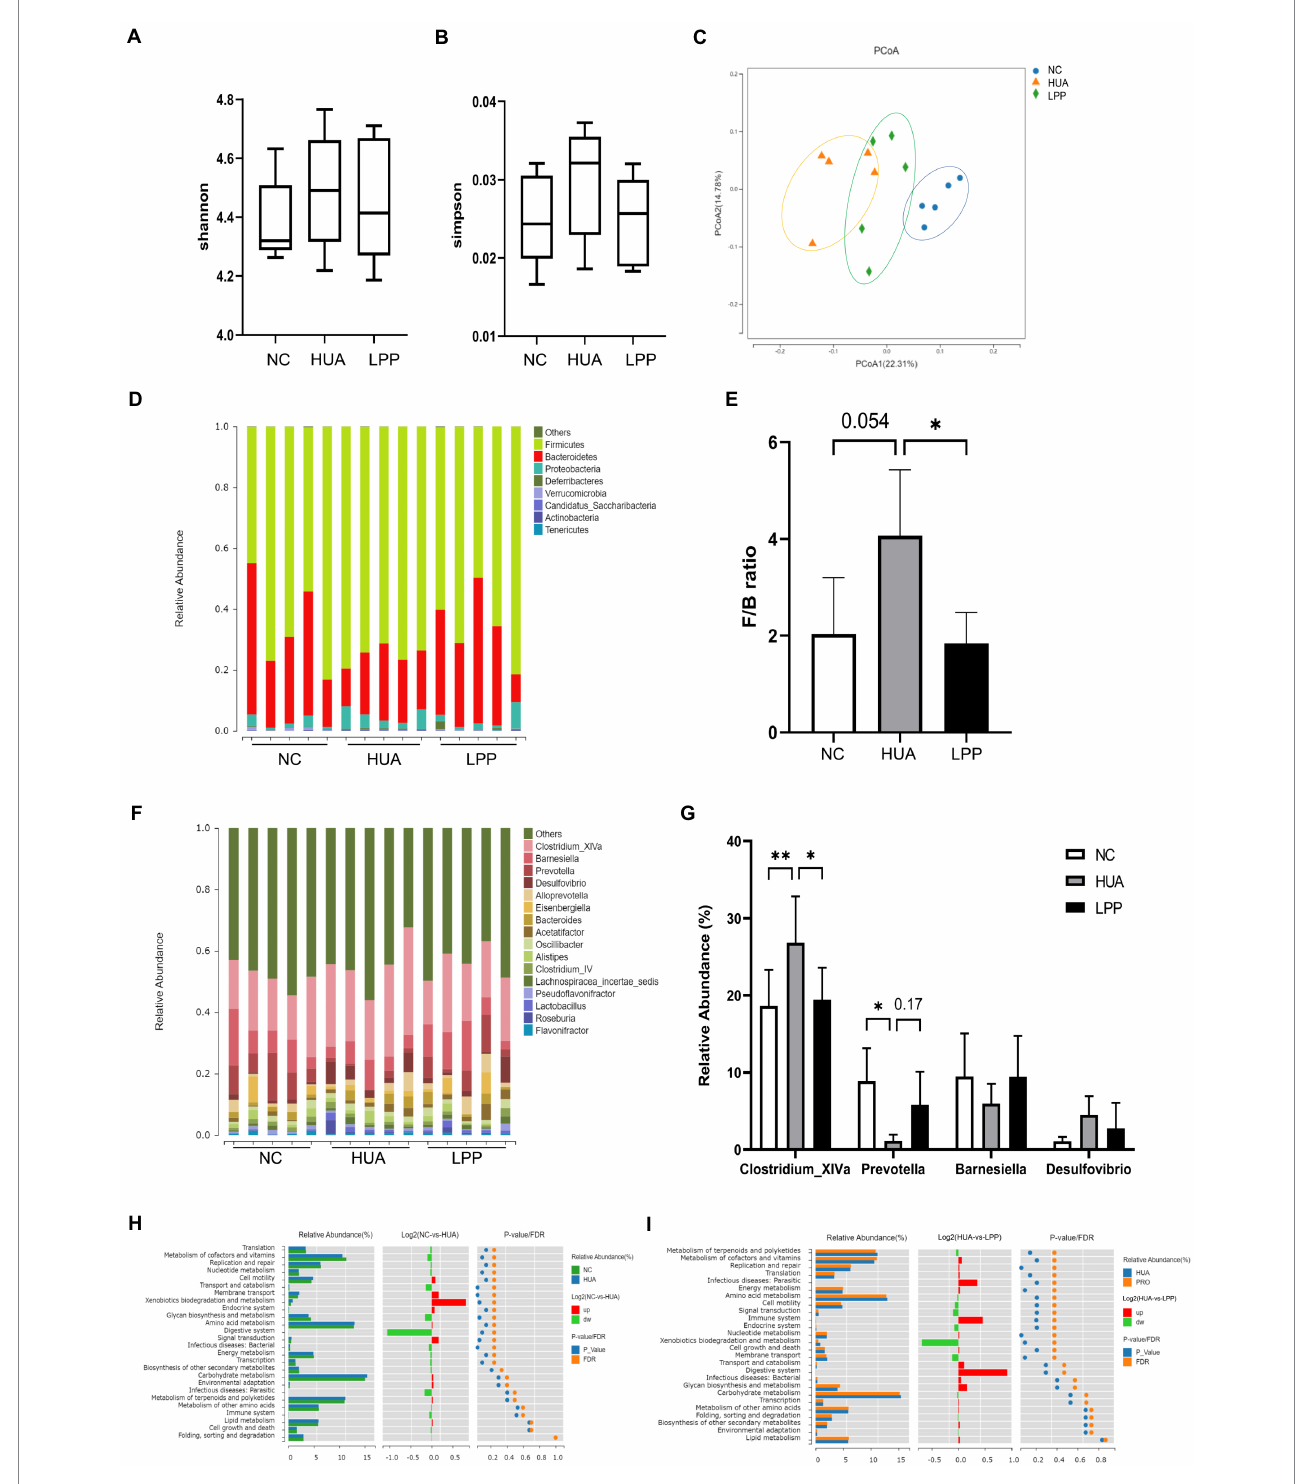
FIGURE 5 LPP restored alteration in gut microbiota of HUA mice. (A,B) Shannon Index and Simpson Index indicated α diversity in different groups. (C) Principal coordinate analysis (PCoA) plot based on unweighted UniFrac distance. (D) Comparison of phylum relative abundance in different groups. (E) The ratio of relative abundance of Firmicutes and Bacteroidetes (F/B ratio). (F) Comparison of genus relative abundance in different groups. (G) Relative abundance of the key differential genus in different groups. (H,I) Predicted microbial function comparisons. Gene functional categories were from level 2 of KEGG pathways. FDR, false discovery rate. (H) Comparing microbial function between the NC mice and HUA mice, the enriched functions in the NC mice were presented with green color and the enriched functions in the HUA mice were presented with blue color. (I) Comparing microbial function between the HUA mice and LPP-treated mice, the enriched functions in the HUA mice were presented with blue color and the enriched functions in the LPP-treated mice were presented with orange color. The nonparametric Kruska Wallis rank-sum test was used followed by Duncan’s test for multiple comparisons for alpha diversity analysis of the gut microbiota. Other data were analyzed by one-way ANOVA followed by post hoc comparisons using Tukey’s test for multiple groups’ comparisons, * p < 0.05; ** p < 0.01; *** p < 0.001; **** p <